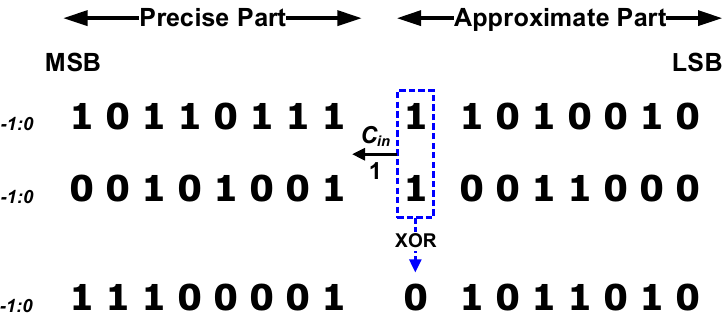
Figure 3. Operation of proposed adder.